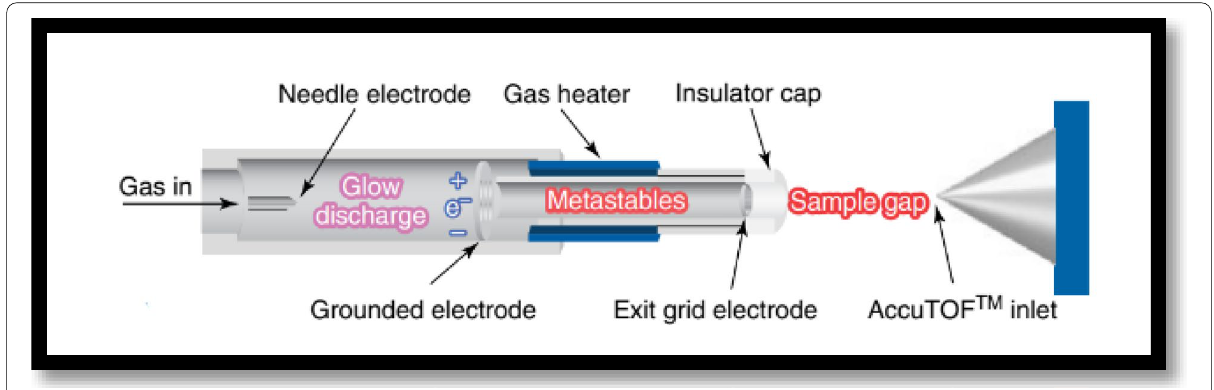
Fig. 1 Schematic diagram of the DART system (Dane